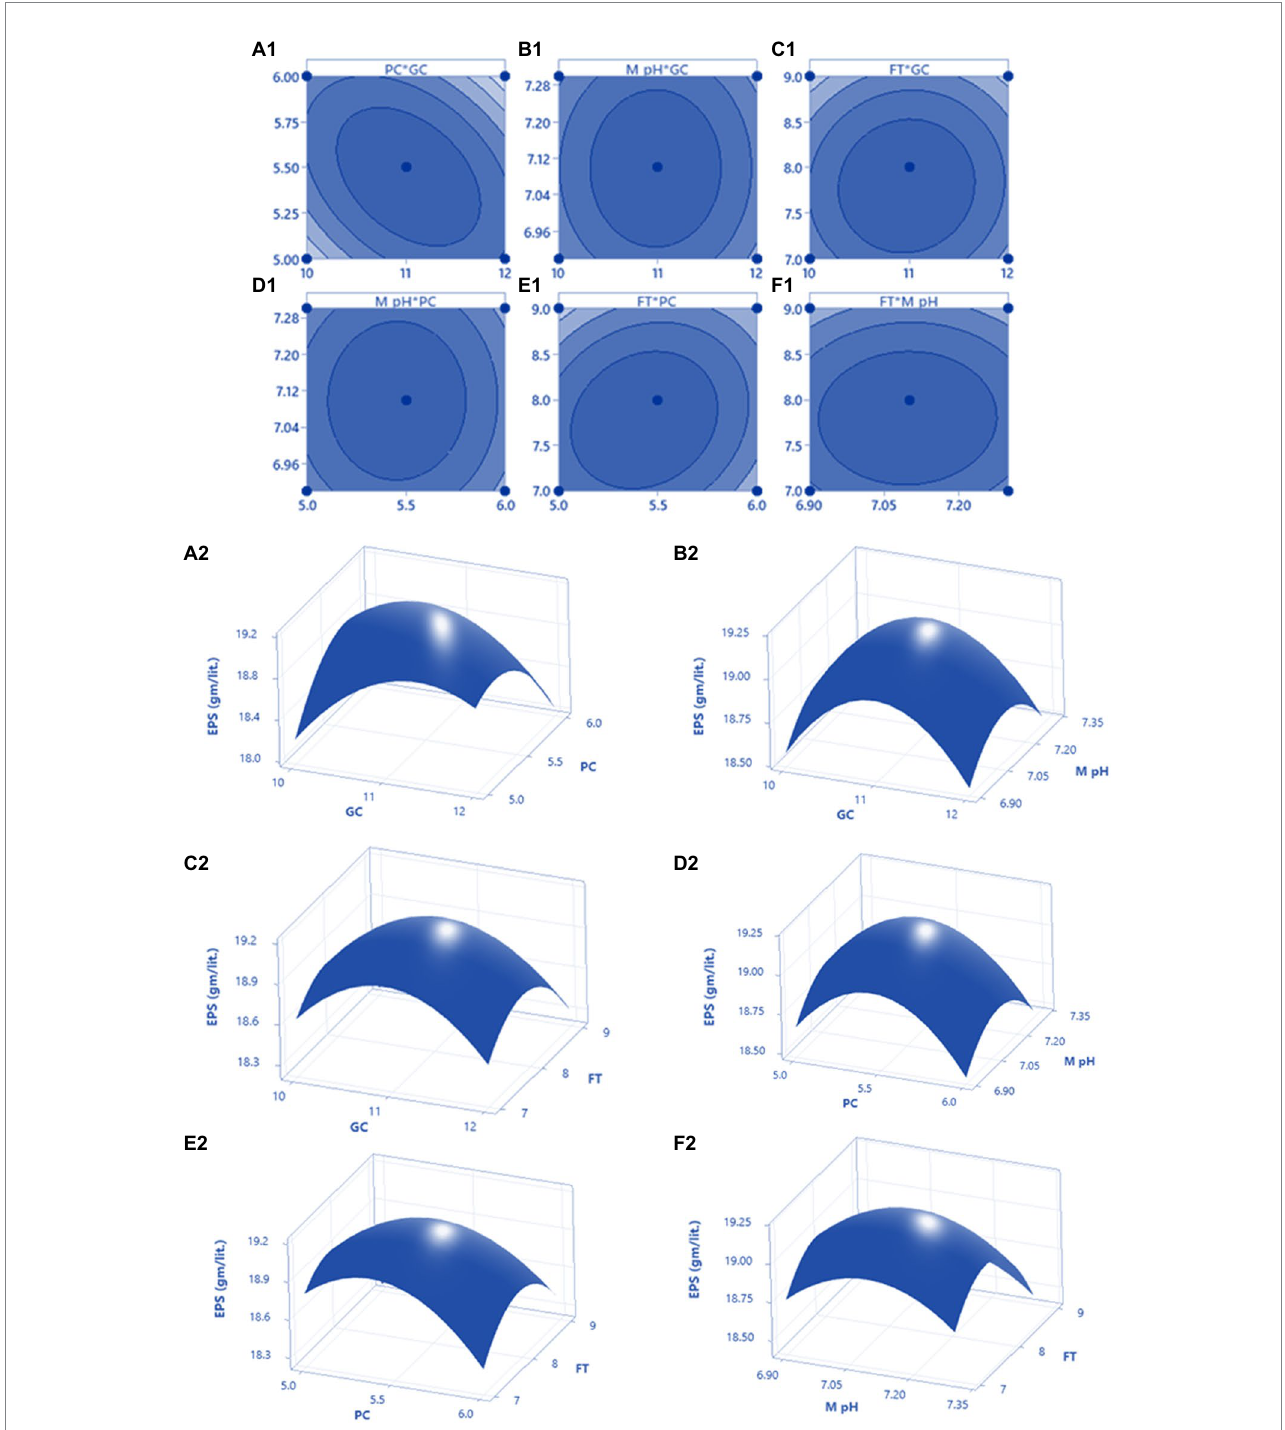
FIGURE 2 The 3D plot with 2D projection and contour plot showing the most important interactions of factors in RSM optimization of GRH production by HELF2. (A1,A2) between peptone concentration (PC) vs. glucose concentration (GC) at fermentation time (FT) 8 days and medium pH 7.1 (MpH); (B1,B2) between MpH (7.1) and GC (11 g L − 1 ) at FT (8 days) and PC (5.5 g L − 1 ); (C1,C2) between FT (8 days) and GC (11 g L − 1 ) at PC (5.5 g L − 1 ) and MpH (7.1); (D1,D2) between MpH (7.1) and PC (5.5 g L − 1 ) at FT (8 days) and GC (11 g L − 1 ); (E1,E2) between FT (8 days) and PC (5.5 g L − 1 ) at MpH (7.1) and GC (11 g L − 1 ); (F1,F2) between FT (8 days) and MpH (7.1) at GC (11 g L − 1 ) and PC (5.5 g L − 1